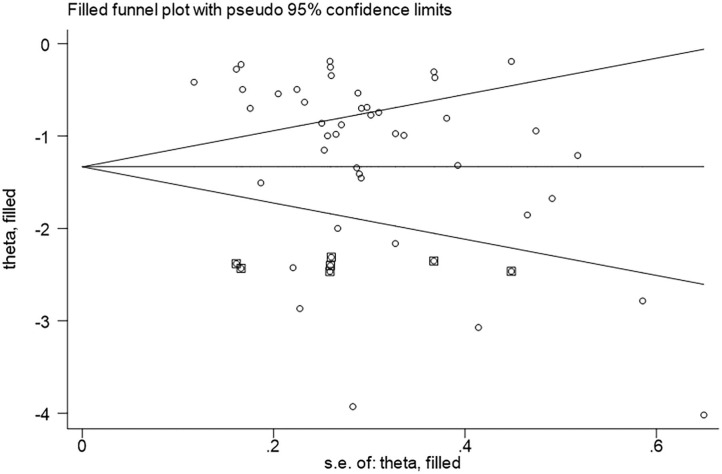
Trim and fill method for evaluating publication bias (the circles alone are real studies and the circles enclosed in boxes are “filled” studies. The horizontal line represents the summary effect estimates, and the diagonal lines represent pseudo-95% CI limits).